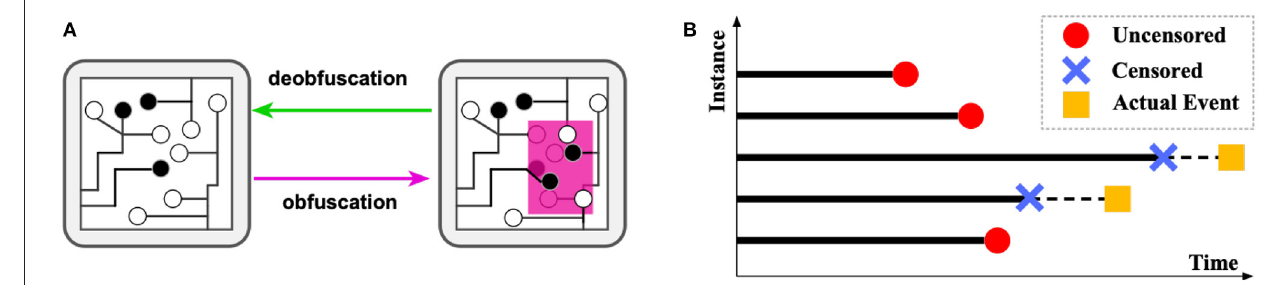
FIGURE 1 | (A) An illustration of obfuscation and deobfuscation. (B) An illustration demonstrating the survival analysis